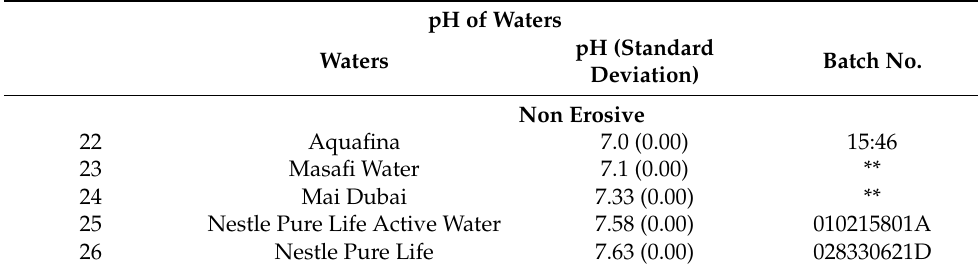
Table 2. pH (mean and standard deviation) of waters.